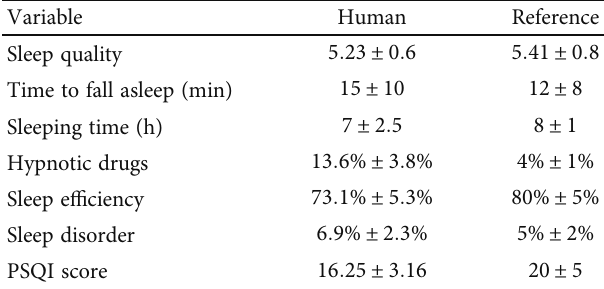
Table 1: Sleep quality and descriptive analysis of each